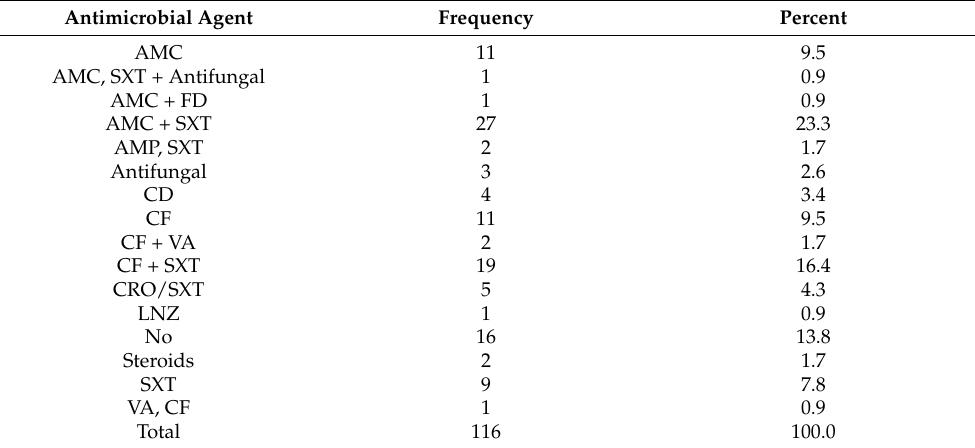
Figure 1. Distribution of study subjects according to the age group. Table 1. Treatment history of patients included in this study at the time of collection of specimens (n = 116).